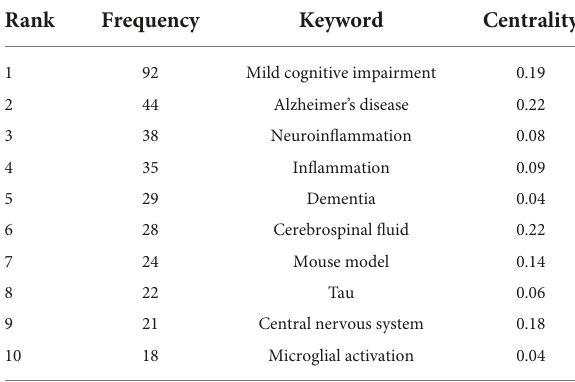
TABLE 7 Keywords with the highest co-occurrence